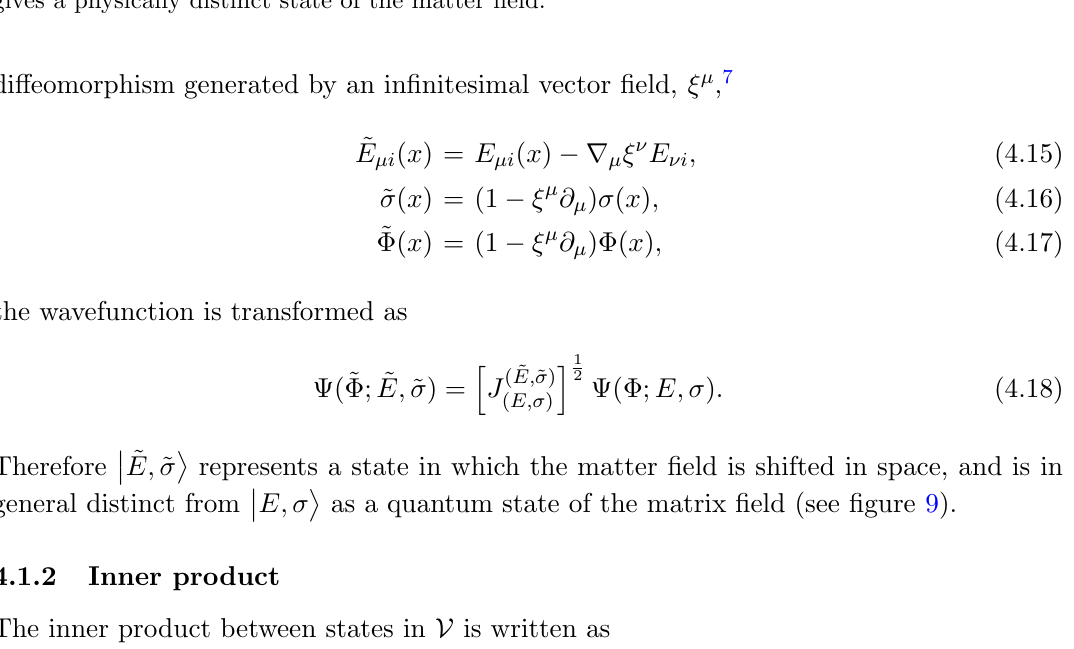
Figure 9 . The curves represent gauge orbits generated by local SO(3) transformations, E 0 O j ( x ) E (cid:22)j , (cid:27) 0 ( x ) = (cid:27) ( x ) in the space of f E (cid:22)i ( x ) ; (cid:27) ( x ) g , where O j i matrices. Con(cid:12)gurations connected by SO(3) transformations represent a same physical state. On the other hand, a di(cid:11)eomorphism, ~ E (cid:22)i ( x ) = E (cid:22)i ( x ) (cid:0) r (cid:22) (cid:24) (cid:23) E (cid:23)i , ~ (cid:27) ( x ) = (1 (cid:0) (cid:24) (cid:22) @ (cid:22) ) (cid:27) ( x ) generally gives a physically distinct state of the matter